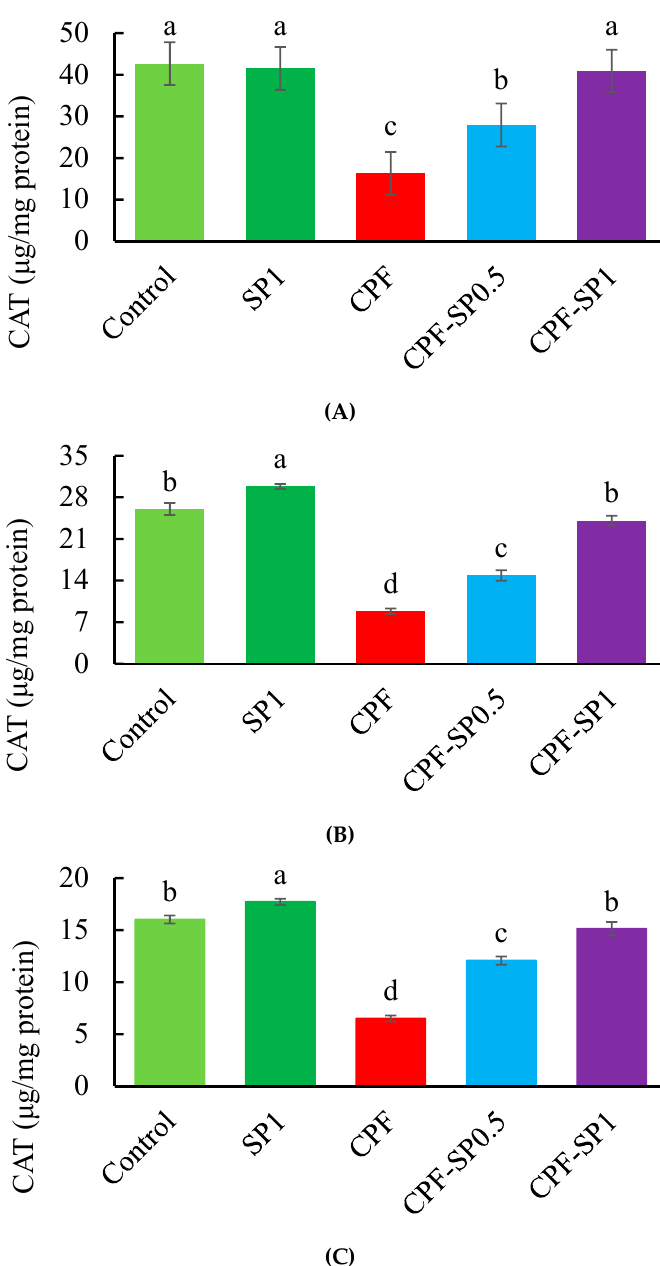
Figure 3. ( A ) Liver, ( B ) kidney, and ( C ) gill catalase (CAT) levels in the treated groups ( μ g/mg protein). Data are presented as means ± SE ( n = 8). Bars with different letters are significantly different ( p ≤ 0.05).